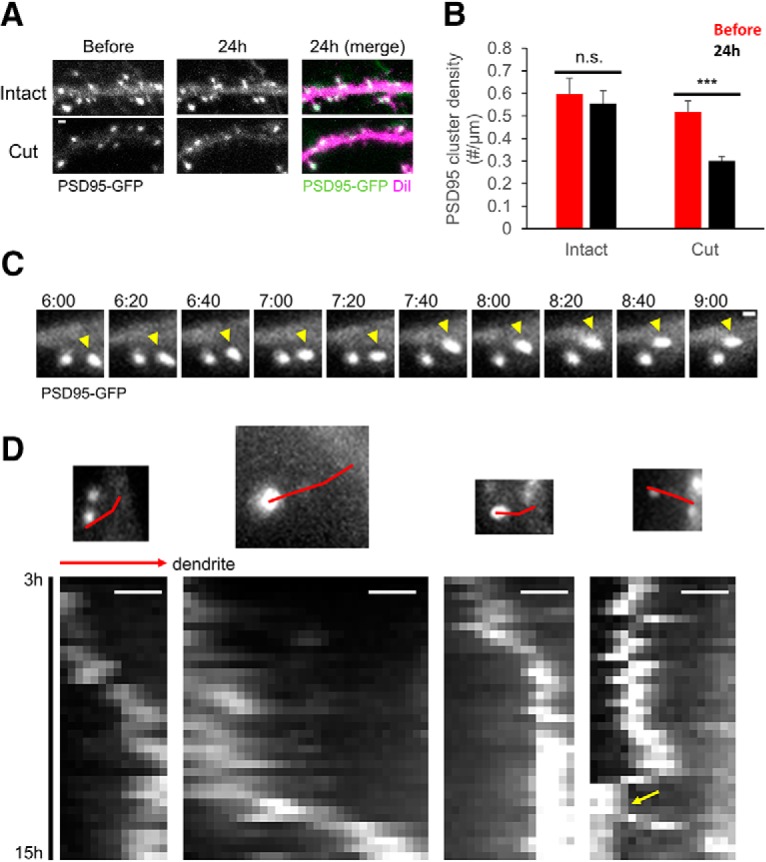
Temporal changes in PSD-95 clusters after afferent elimination. A, Confocal images of dendrites with or without afferent elimination. Images of PSD-95-GFP in the same dendrites before and 24 h after the manipulation. The pseudo color images are overlay of PSD-95-GFP (green) and DiI (magenta) 24 h after the manipulation. B, PSD-95-GFP cluster densities before and 24 h after afferent elimination. C, Time-lapse images of a PSD-95-GFP cluster moving toward a dendritic shaft. Movement of the right cluster (yellow arrowheads) became evident at 7 h 40 min after the manipulation. D, Kymographs of moving PSD-95-GFP clusters. Each image on top shows PSD-95-GFP clusters at 3 h after afferent elimination. A red line in each image on top shows the trajectory of cluster movement, along which the bottom kymograph was generated. Some PSD-95-GFP clusters split (a yellow arrow in the rightmost kymograph) and only one of the two clusters move toward the dendritic shaft. The kymographs start and end at 3 and 15 h after afferent elimination. Direction toward dendritic shafts are indicated by a red arrow. Error bars are SEM; ***p < 0.001, n.s. = not significant. Scale bars = 1 μm.